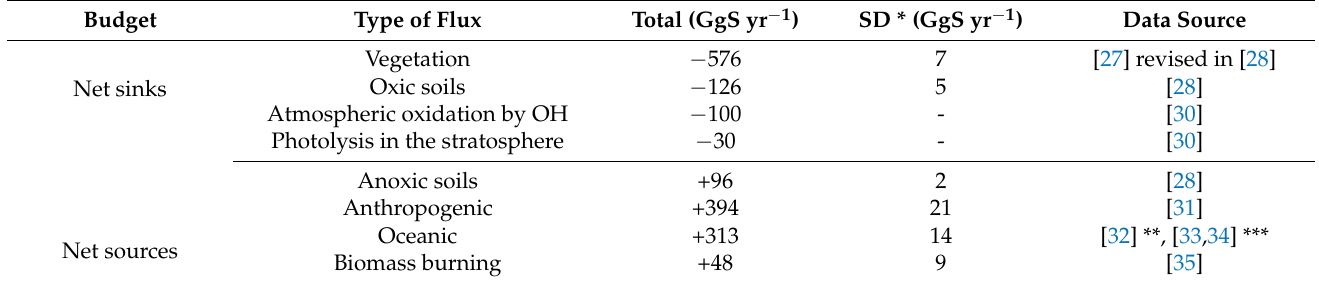
Table 1. Fluxes from the different COS source and sink components. Mean magnitude and standard deviations of the fluxes are given for the period